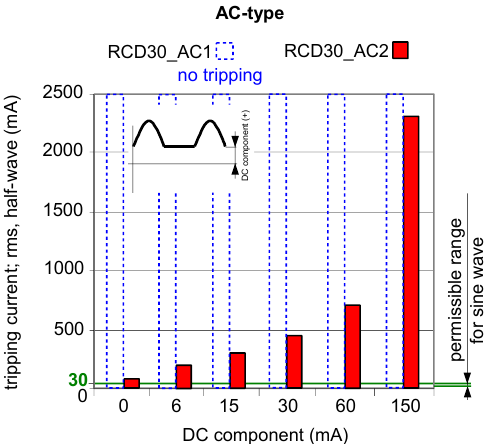
Figure 13. Tripping current (rms value of the DC pulsating component) of two 30 mA AC-type RCDs under pulsating DC (half-wave) current superimposed by smooth DC component of values 6, 15, 30, 60, and 150 mA. Both components have positive (+) polarity.